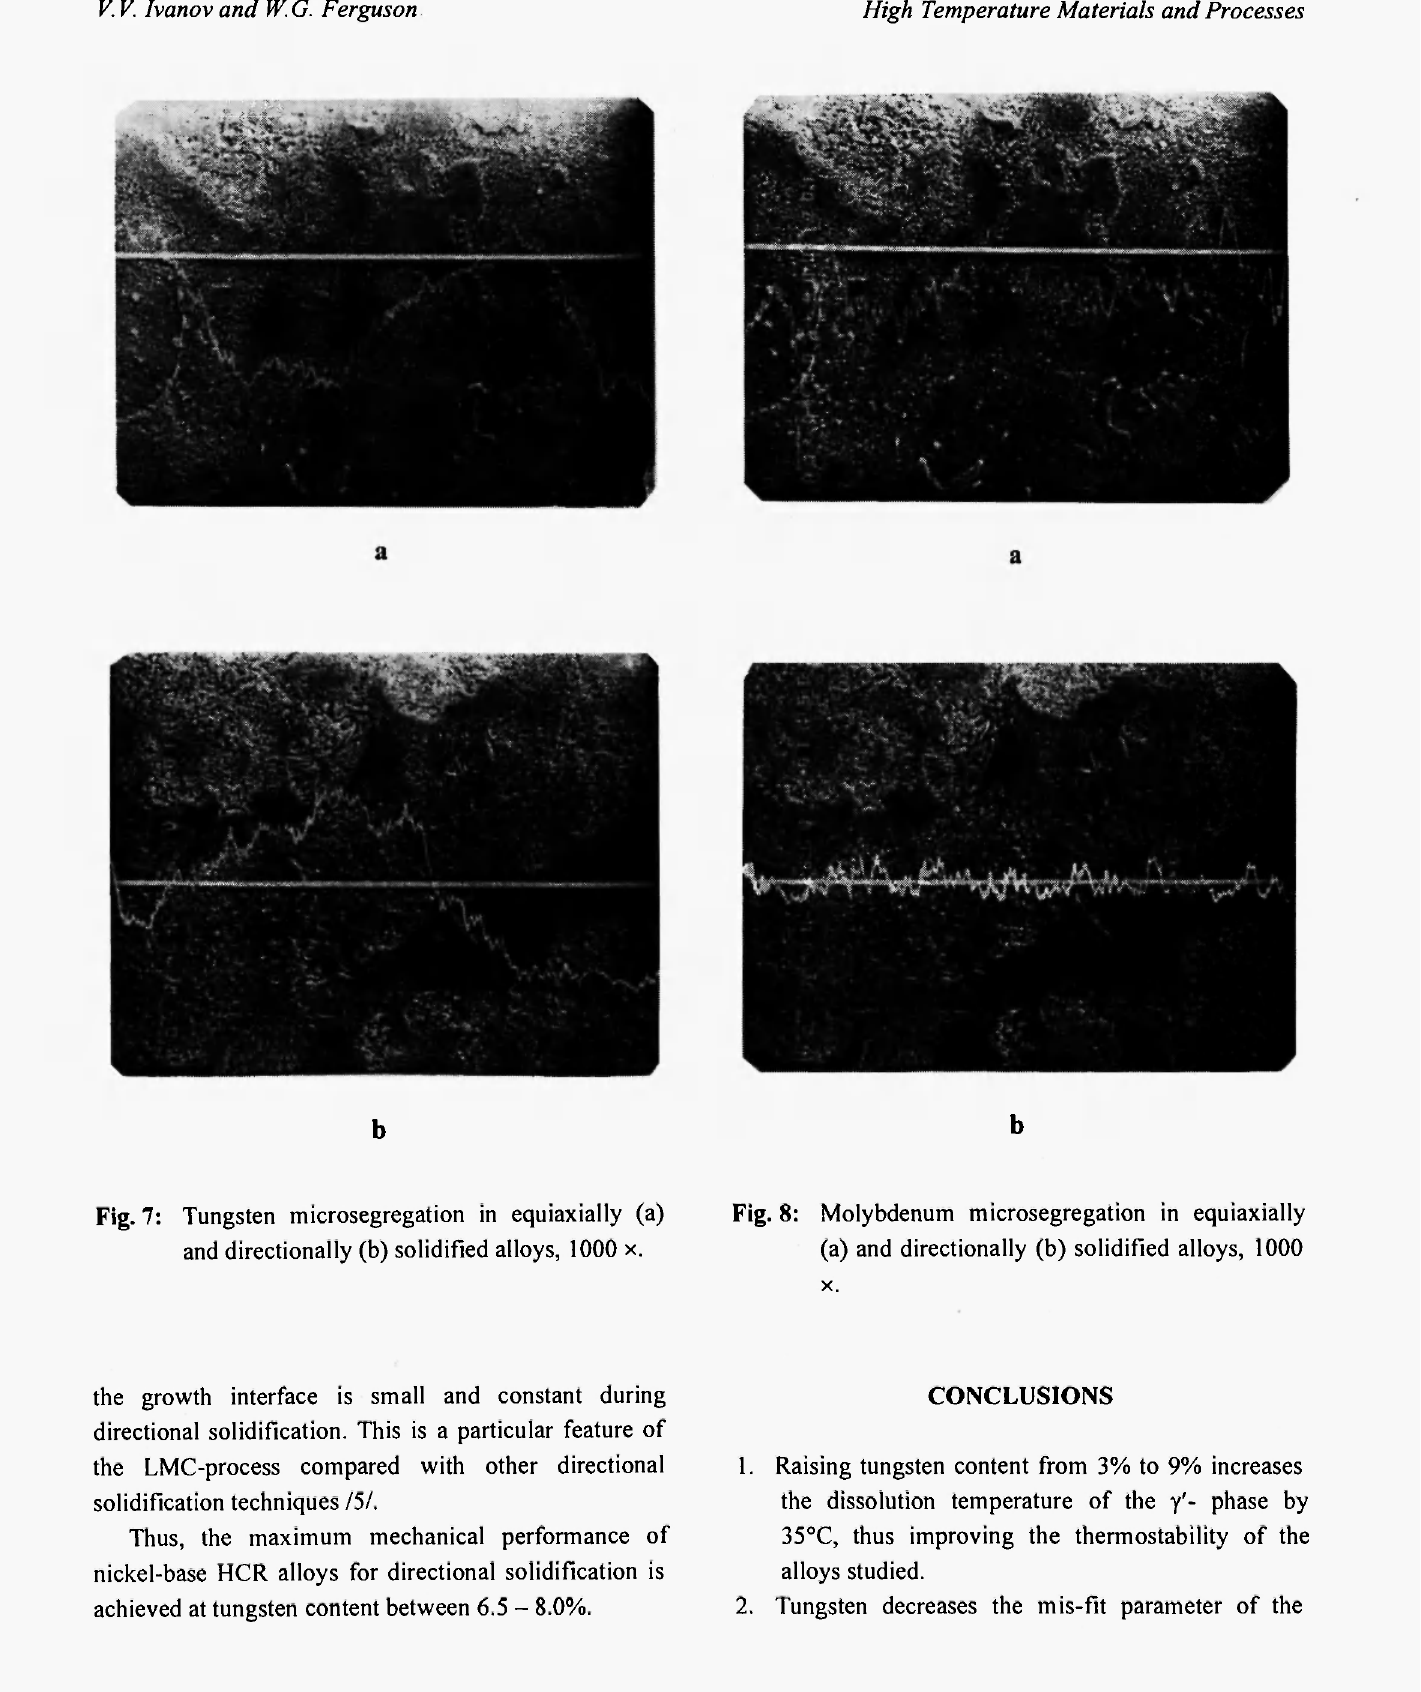
Fig. 7: Tungsten microsegregation in equiaxially (a) and directionally (b) solidified alloys, 1000 x.